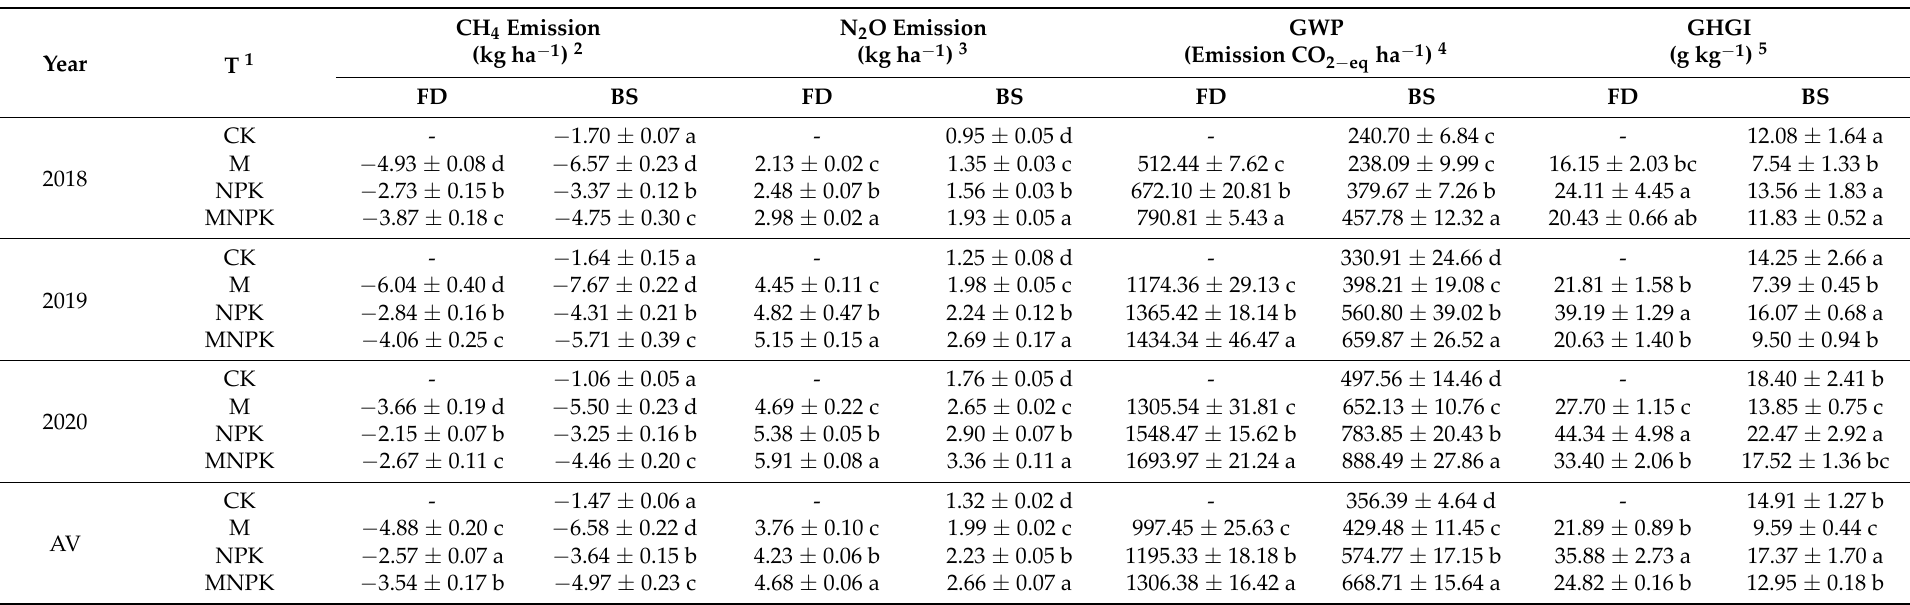
Table 3. Total greenhouse gases emission (CH 4 and N 2 O) and comprehensive greenhouse effect under different fertilization